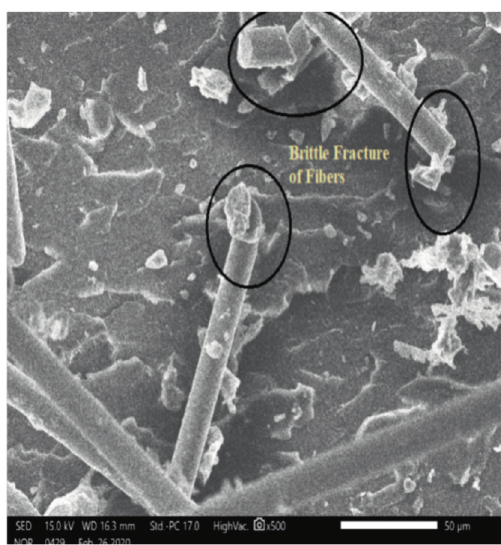
Figure 9: Scanning electron microscopy image of shear test specimen with white cement filler of 10